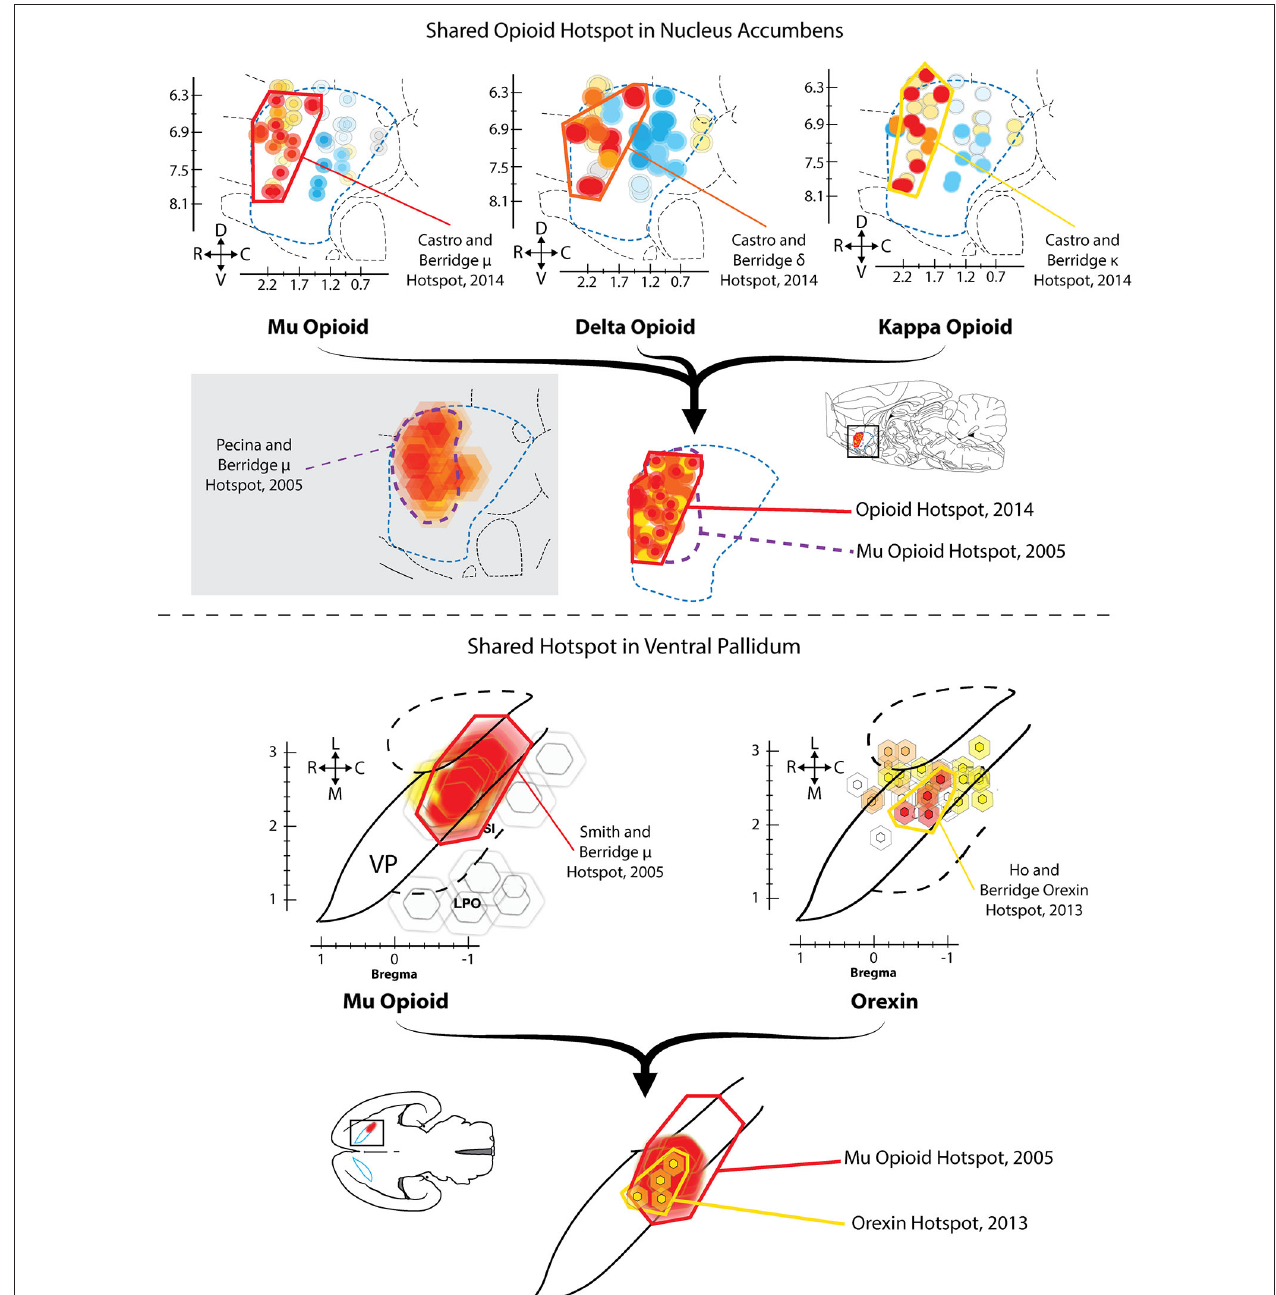
to baseline (overlapping sites shown adjacently). Mu effects are depicted in red, delta in orange, and kappa in yellow (Modified from Castro and Berridge, 2014). Bottom : Horizontal maps of VP similarly show sites where mu opioid (left) or orexin stimulation increased hedonic reactions. A shared hedonic hotspot is revealed in posterior VP, where either mu opioid or orexin stimulation increased hedonic reactions by at least 150% compared to vehicle baseline in the same rats. Mu is colored red, and orexin is colored yellow (Modified from Ho and Berridge, 2013).